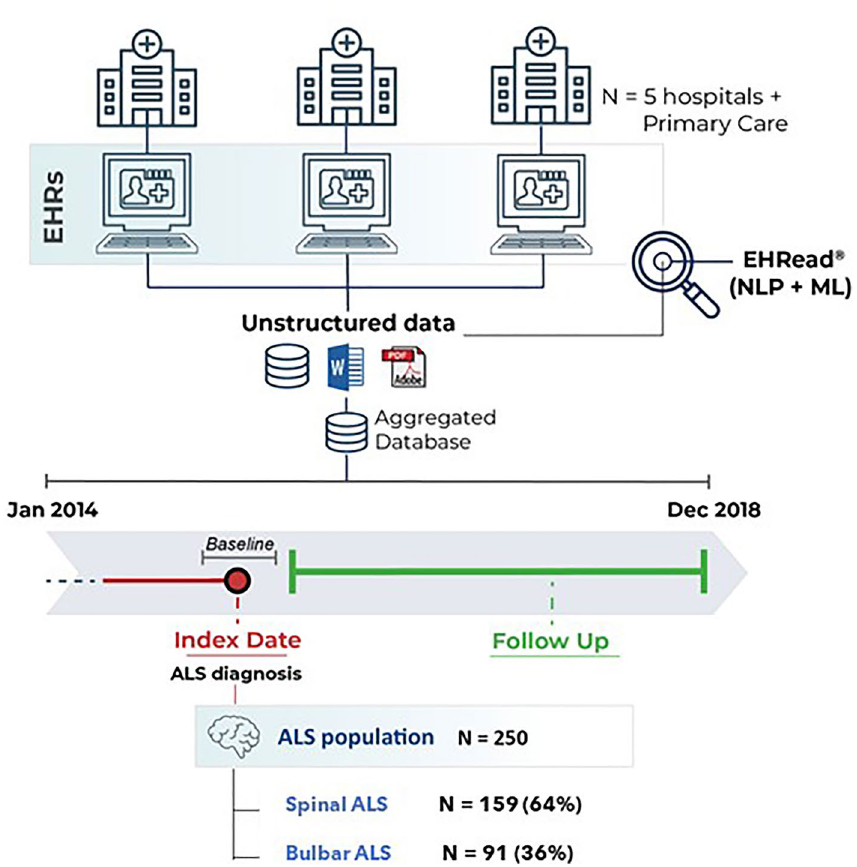
Figure 1. Study design and population. Using the EHRead® technology, the unstructured clinical data from patients’ EHRs were extracted and analyzed at two different time windows, namely Index Date and Follow Up (see Methods for details). From a source population of all attended individuals in the participating hospitals at least once during the study period, a total of 250 patients diagnosed with ALS were identified. EHRs electronic health records, ML machine learning, NLP natural language processing; ALS amyotrophic lateral